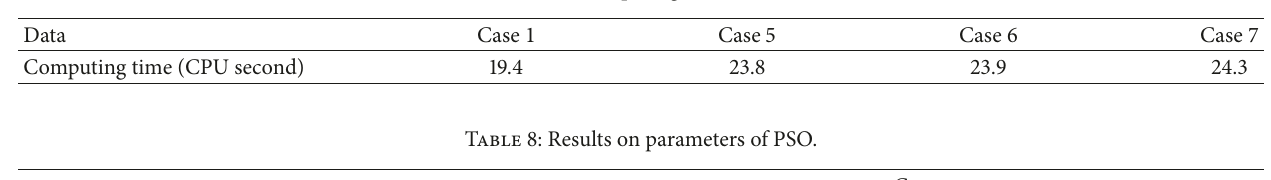
Table 7: Computing time of DE.